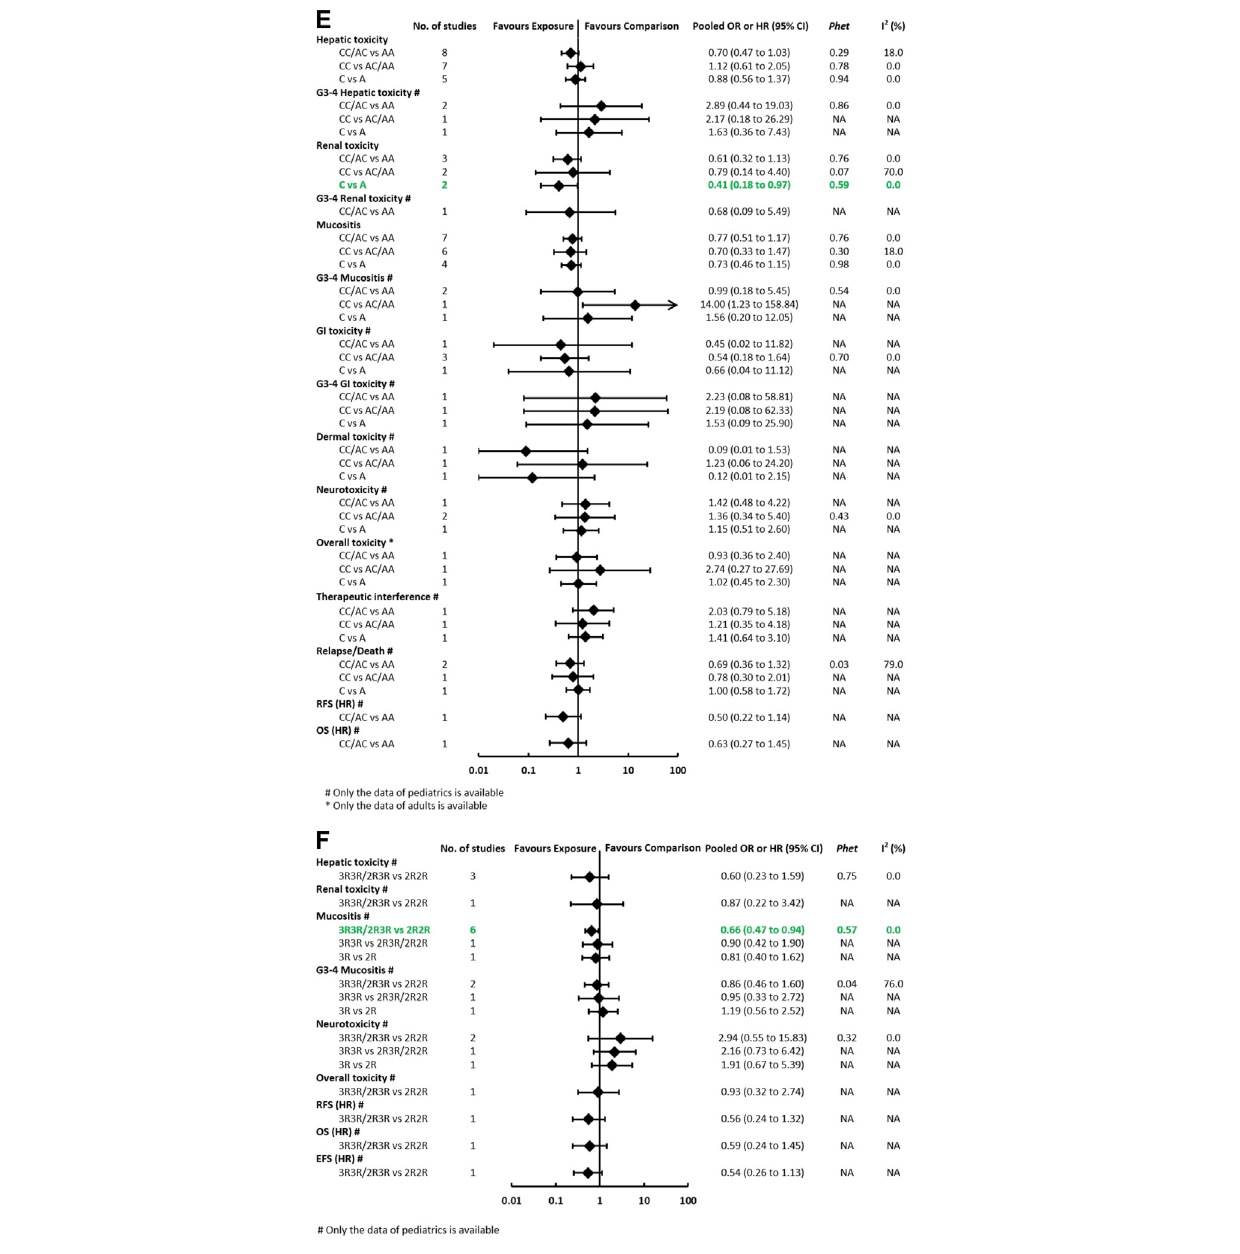
three genetic models is summarized at Figure 3 and Supplementary Table S8 . Regarding toxicity outcomes, signi fi cant associations were found in the outcomes of